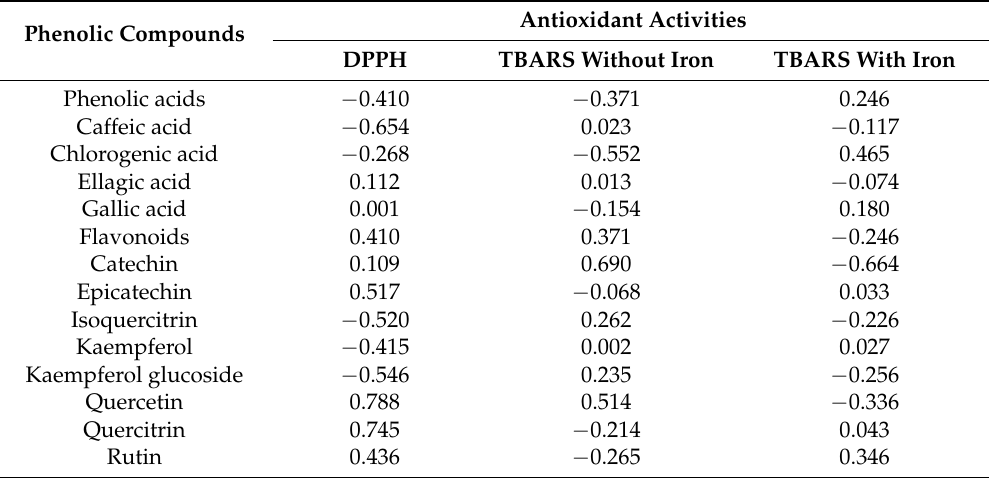
Table 6. Partial correlation coefficients between phenolic compounds composition (HPLC) versus antioxidant